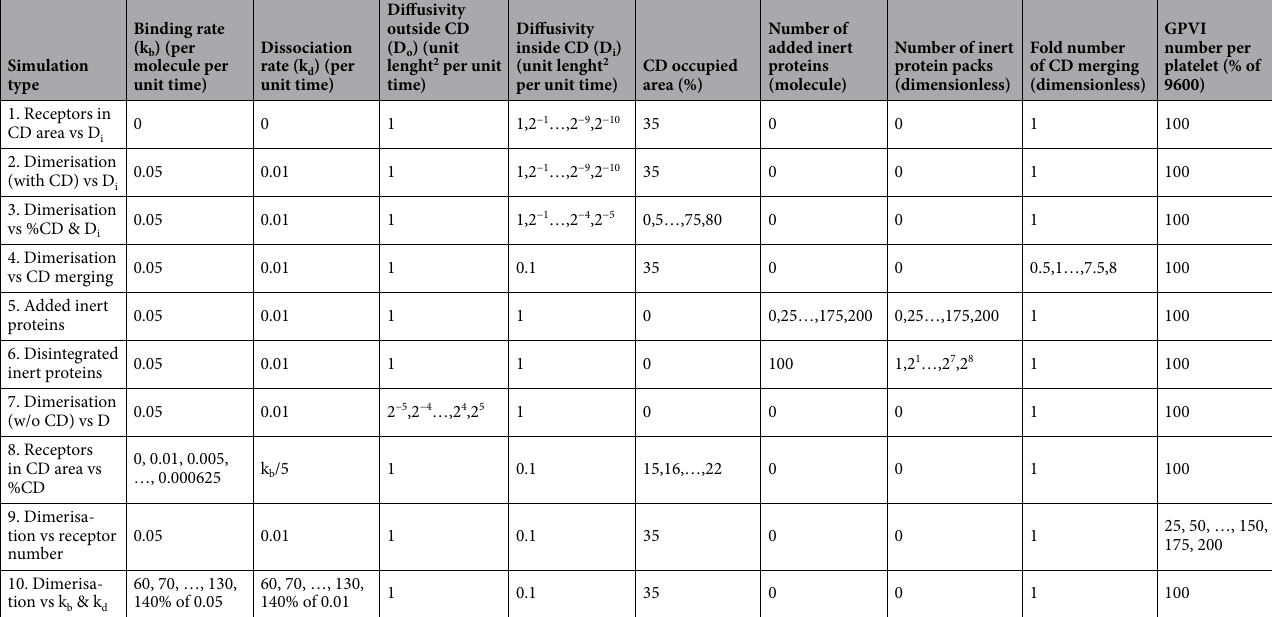
Table 2. List of parameters used in each simulation. CD, confined domain. Please note in this context, k d and k b are implemented as a rate in unit time as described in the “Methodology”